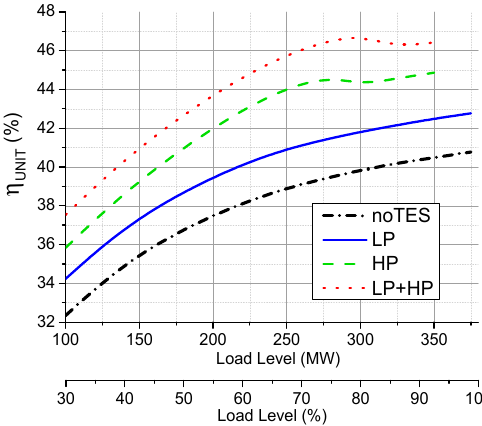
Figure 19. Unit efficiency ( η UNIT ) in the TES discharging process where, no TES: no preheater substitution; LP: low pressure feedwater preheater bypass; HP: high pressure feedwater preheater bypass; HP + LP: both LP and HP feedwater preheaters bypass.